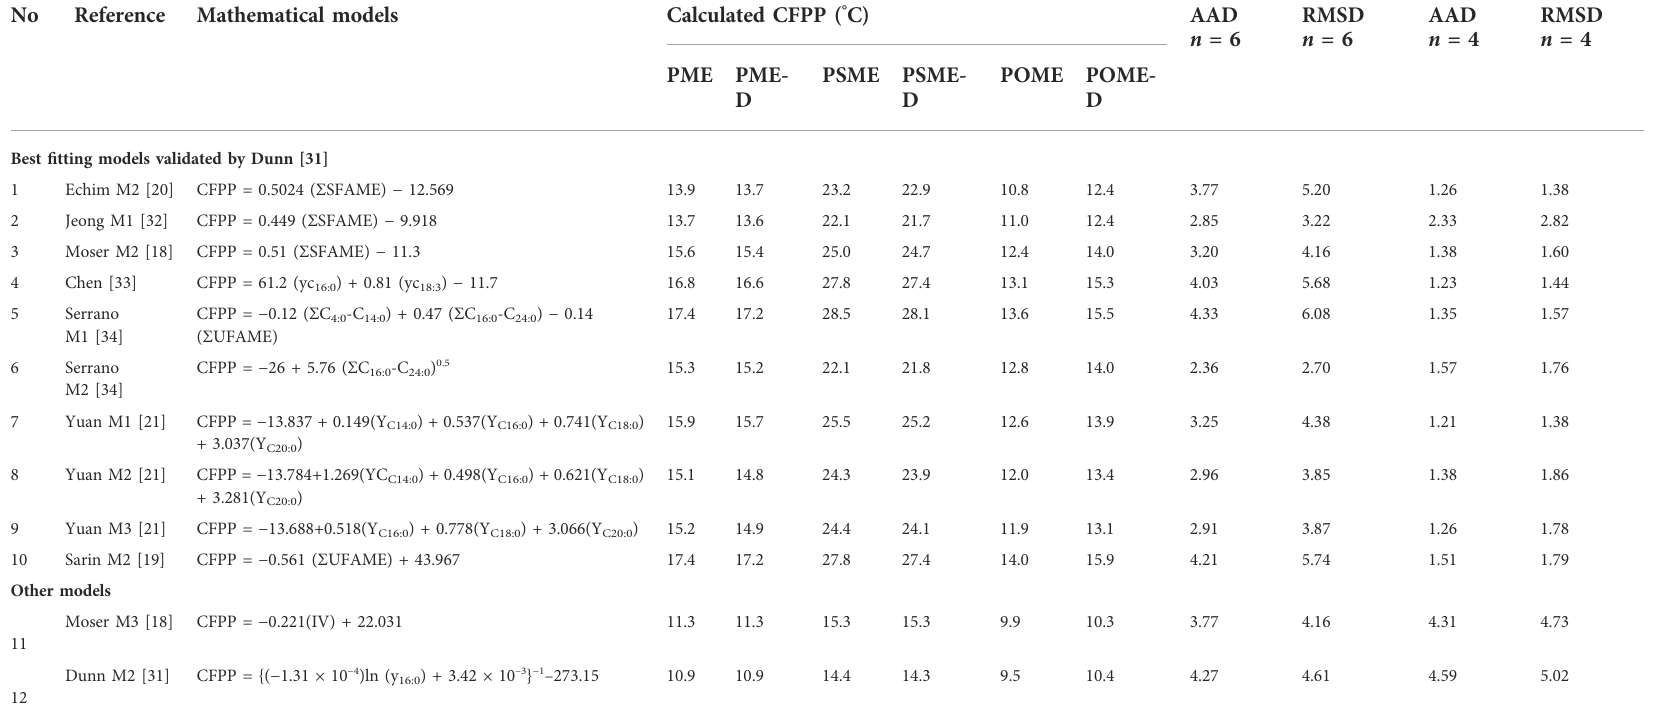
TABLE 2 CFPP prediction of unblended palm biodiesels in distilled and non-distilled forms. No Reference Mathematical